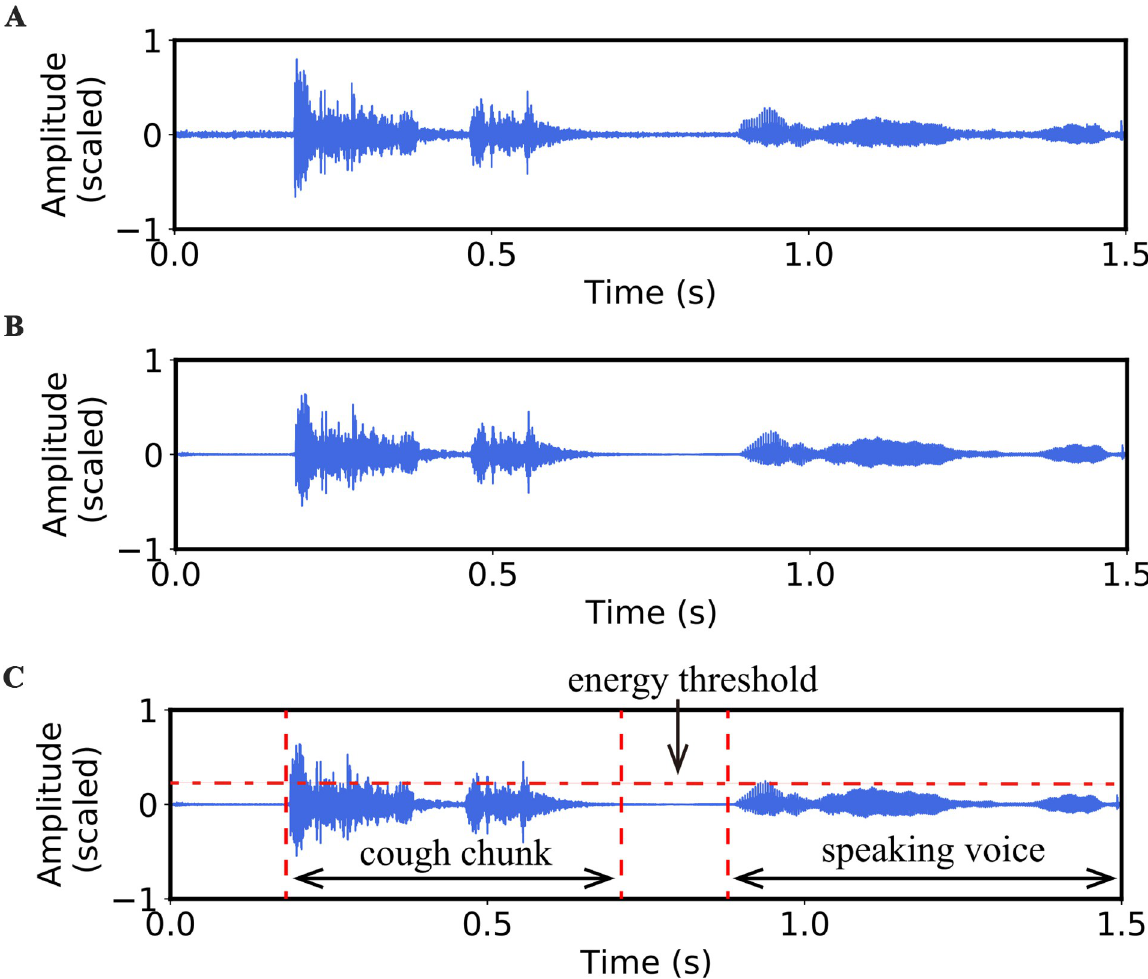
Fig 5. Example of preprocessing and patient audio segmentation waveforms. (A) Waveform of the original patient audio; (B) Waveform after noise reduction and normalization; (C) Waveform after patient audios segmentation according to the energy threshold.